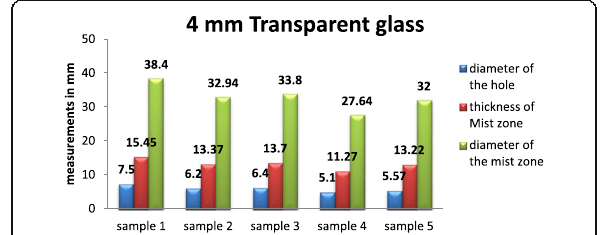
Fig. 6 Graphical Representation of Measurements for 4 mm Transparent glass